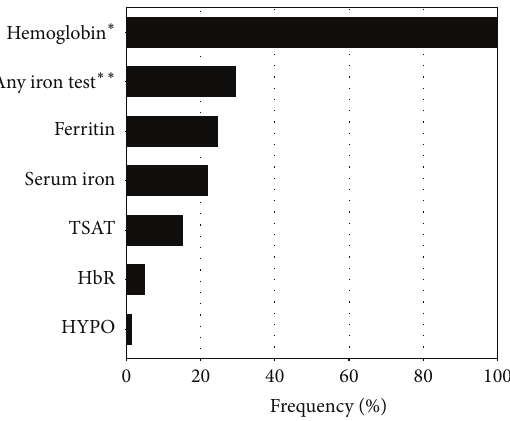
Figure 3: Frequency of patients tested for iron parameters at the start of antianemic treatment. ∗ Inclusion criterion; ∗∗ Patients tested for any of the listed iron parameters: ferritin, serum iron, TSAT (transferrinsaturation),HbR(hemoglobincontentofreticulocytes), or HYPO (hypochromic